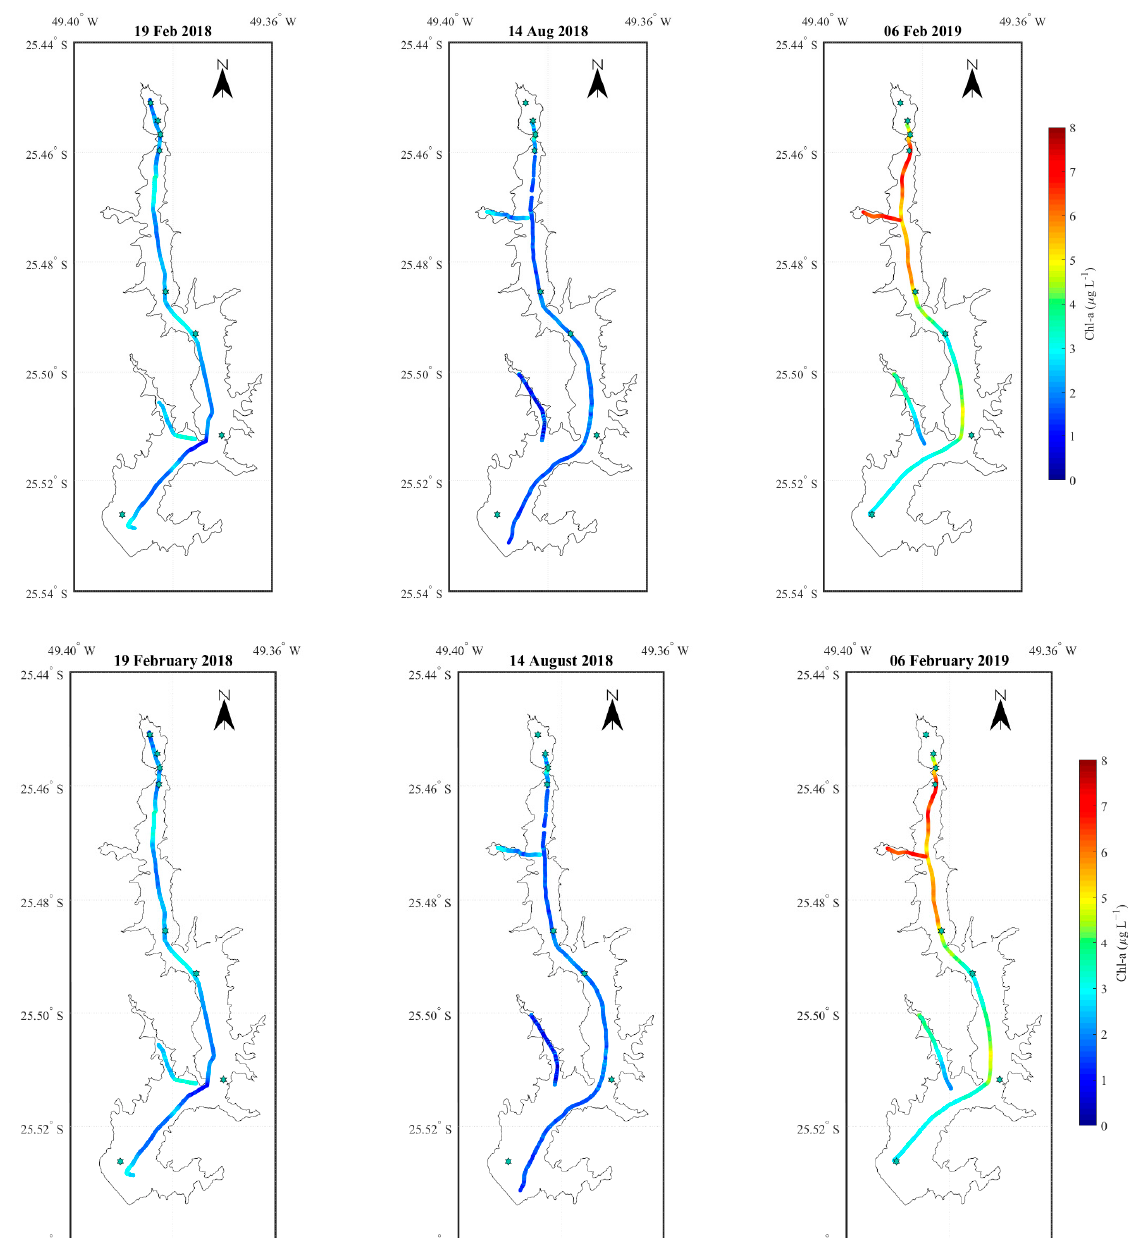
Figure 5. Longitudinal transects of chla at the water surface (~1 m depth), measured with the FluoroProbe sensor during the three extensive sampling campaigns (the sampling date indicated in the title of each panel).